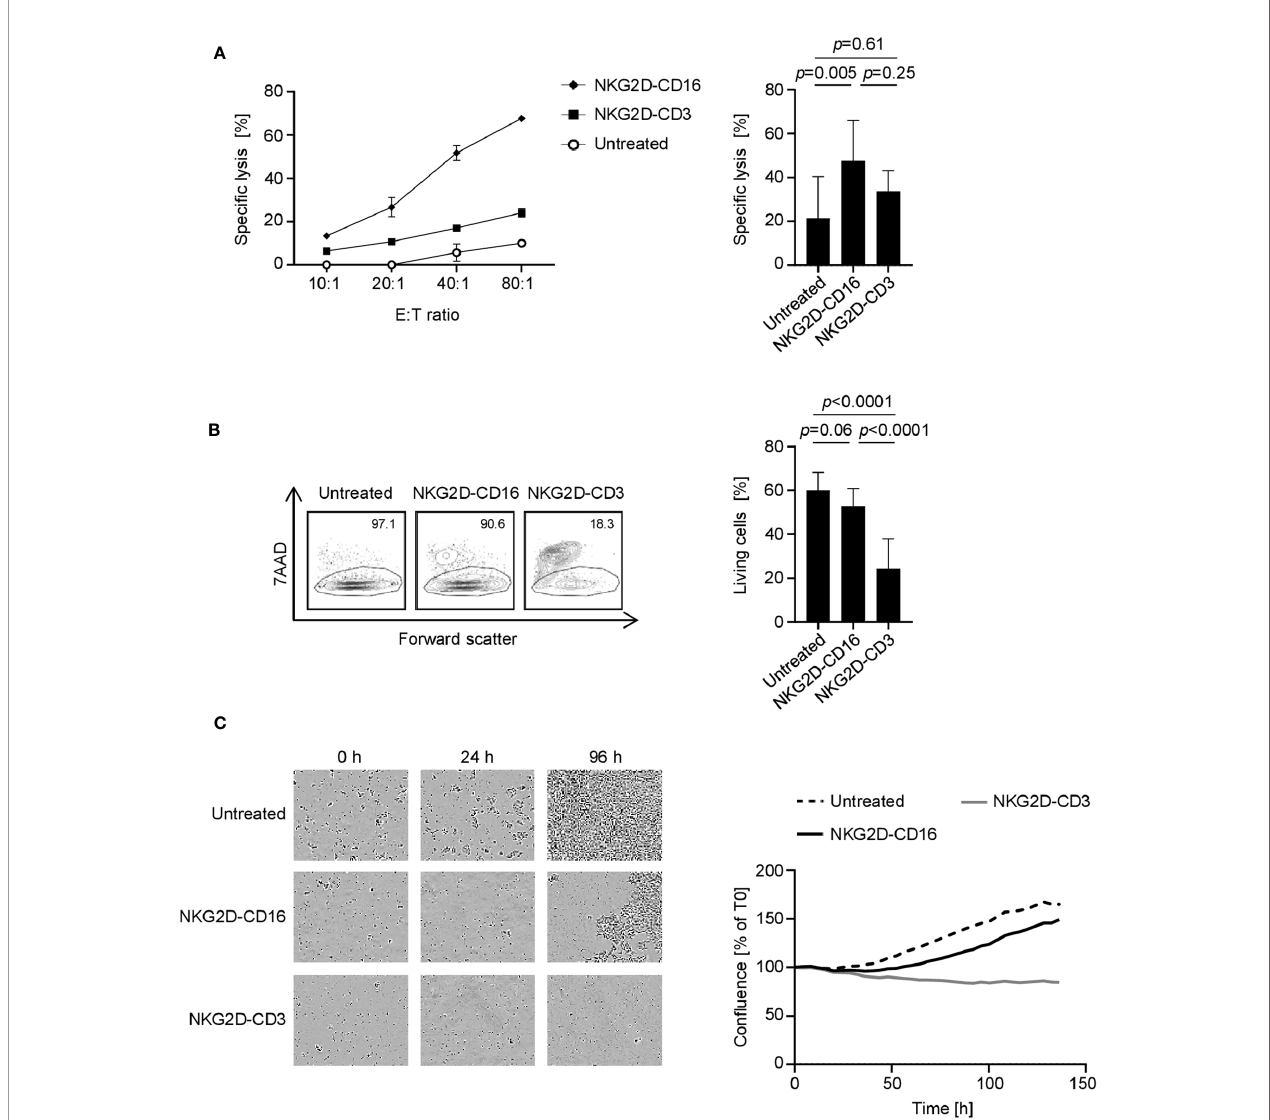
FIGURE 6 | Induction of target cell lysis by NKG2D-CD16/NKG2D-CD3. PBMC of healthy donors (n=4) were incubated with different sarcoma cell lines and treated with the indicated constructs (2.5 µg/mL). (A) Lysis of sarcoma cell lines SaOs, RD-ES and SW1353 (n=3) was analyzed by 2 h Europium cytotoxicity assays. On the left, exemplary data obtained with SaOS with different E:T ratios and on the right pooled data obtained with PBMC of healthy donors at an E:T ratio of 40:1 are shown. (B) Lysis of sarcoma cell lines SaOs, RD-ES and SW1353 (n=3) was determined by fl ow cytometry based lysis assay (E:T 2.5:1) using PBMC of healthy donors. In the left panel, exemplary dot plots with SW1353 and one PBMC donor are shown; the right panel depicts pooled data. (C) Cell death of sarcoma cells was determined using a live cell imaging system. Cells were incubated with PBMC of healthy donors at an E:T ratio of 5:1 for 136 h. In the left panel, representative pictures at 0, 24, and 96 h are displayed. In the right panel, pooled data with two different cell lines are